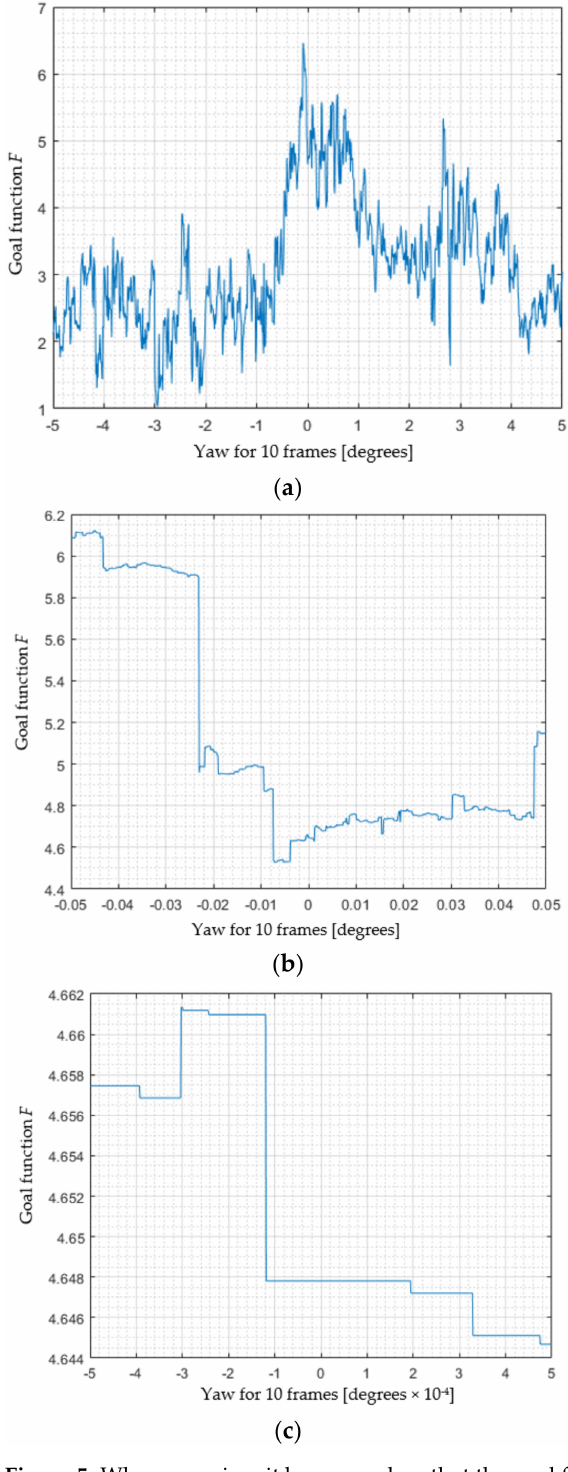
Figure 5. When zooming, it becomes clear that the goal function F is a piecewise constant function. Range [ − 5, 5] ( a ) zoomed in 100 times ( b ) and 10,000 times ( c